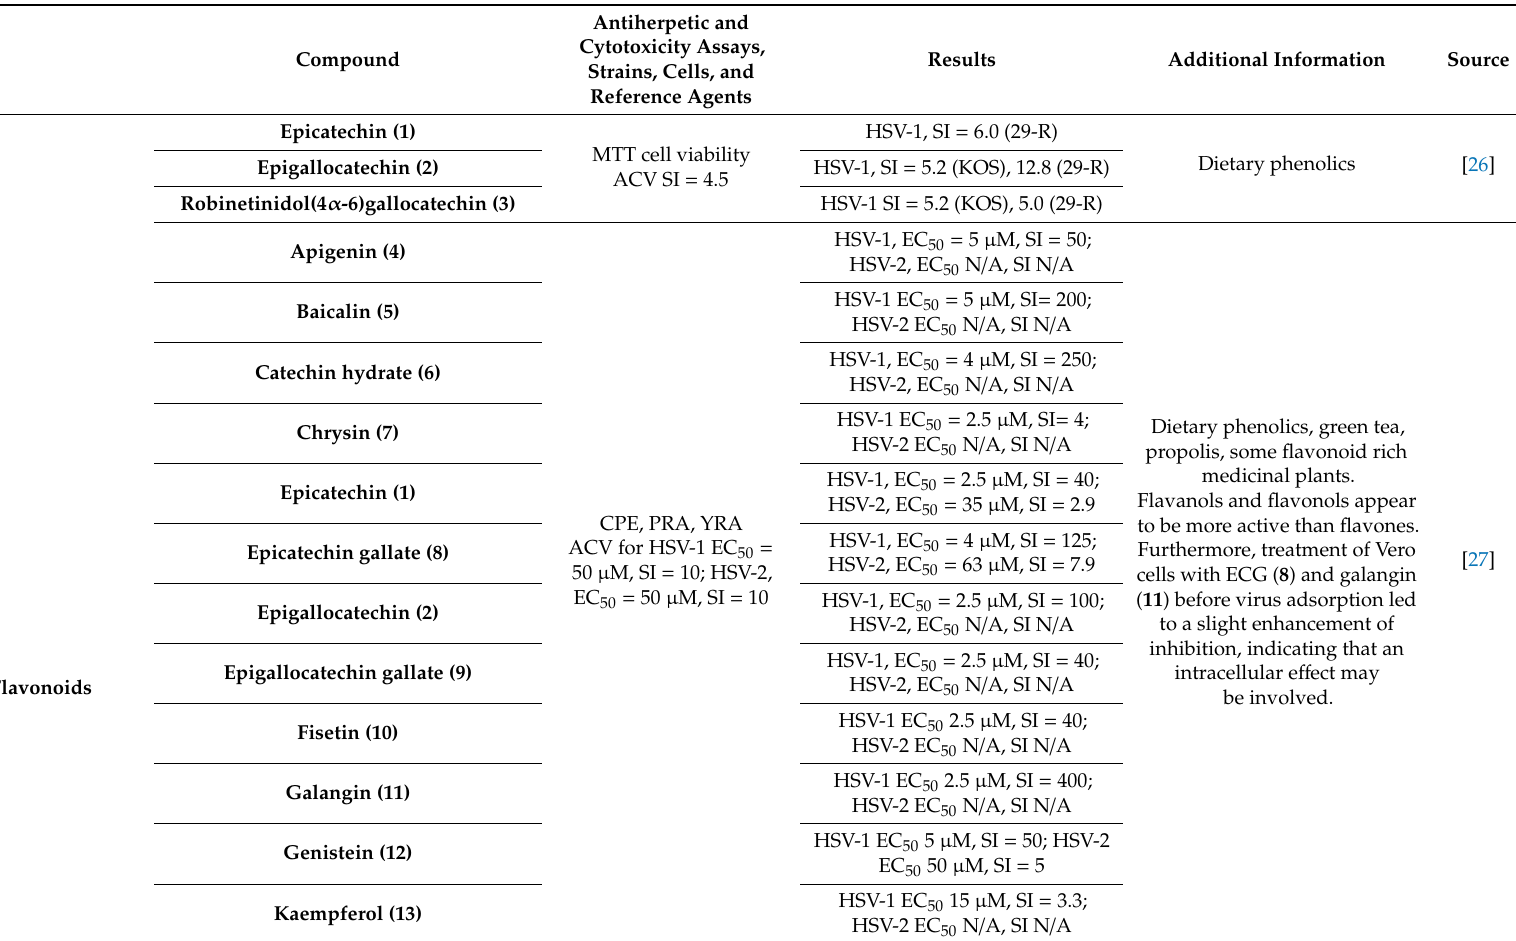
Table 1. The overview of phenolic compounds with anti-HSV